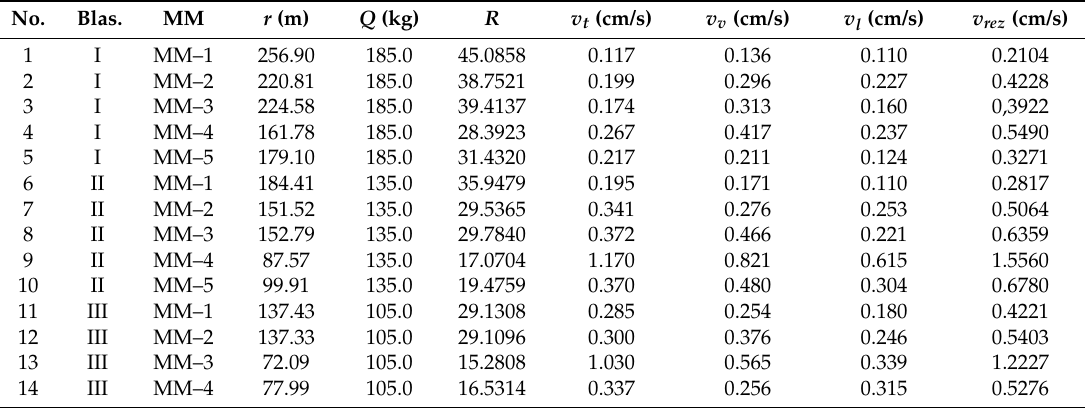
Table 5. Survey of blasting parameters and measurement results in Nepriˇcava open pit.